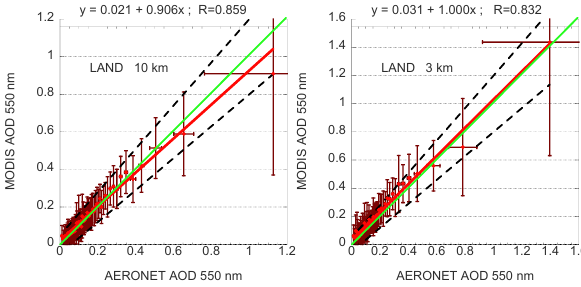
Fig. 12. Binned scatter plot of MODIS AOD at 550nm retrieved from over land against AERONET observed AOD. MODIS 10km product on the left and 3km product on the right. Each bin repre- sents 50 collocations. AERONET AOD has been interpolated to this wavelength to match MODIS. Error bars represent ± 1 standard de- viation in the bin. The green line is the 1:1 line. The red line is the linear regression through the full database of 3252 and 2928 collo- cations for 10km and 3km, respectively. The dashed lines represent expected error of the MODIS 10km retrieval. The range of the axes in each plot are different. Regression statistics are given in Table